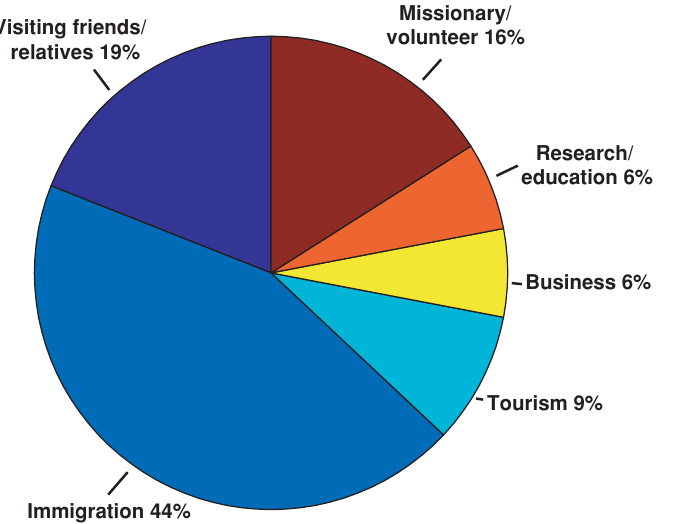
Figure 2. Patient classification among persons with filarial infections reported in the GeoSentinel Surveillance Network.